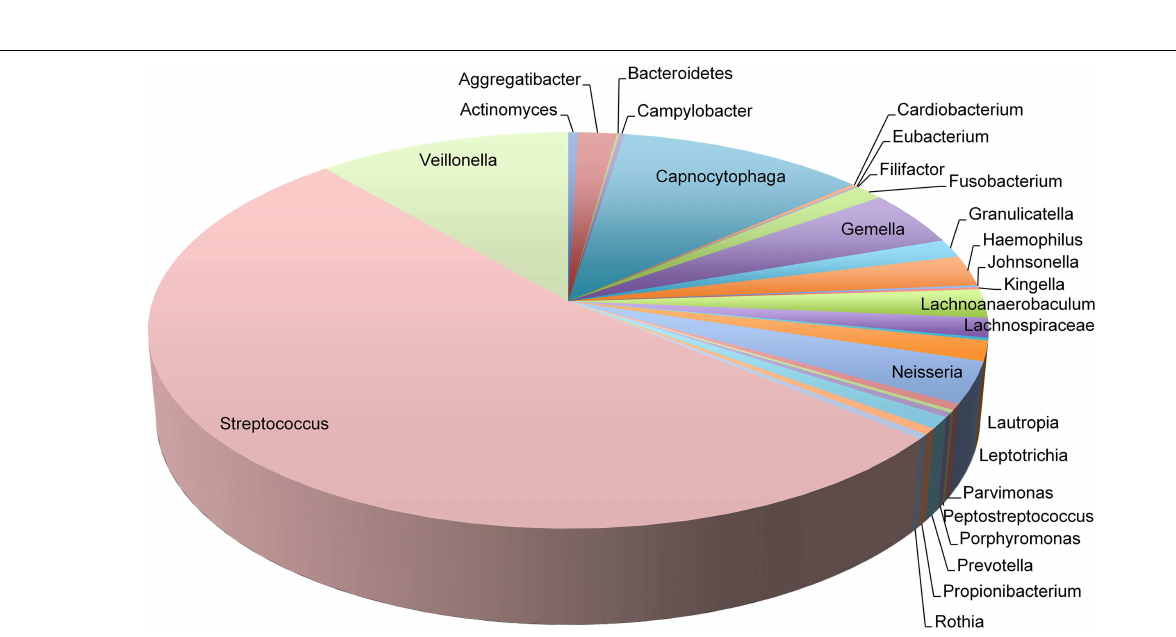
Frontiers in Cellular and Infection Microbiology www.frontiersin.org August 2014 | Volume 4 | Article 108 |